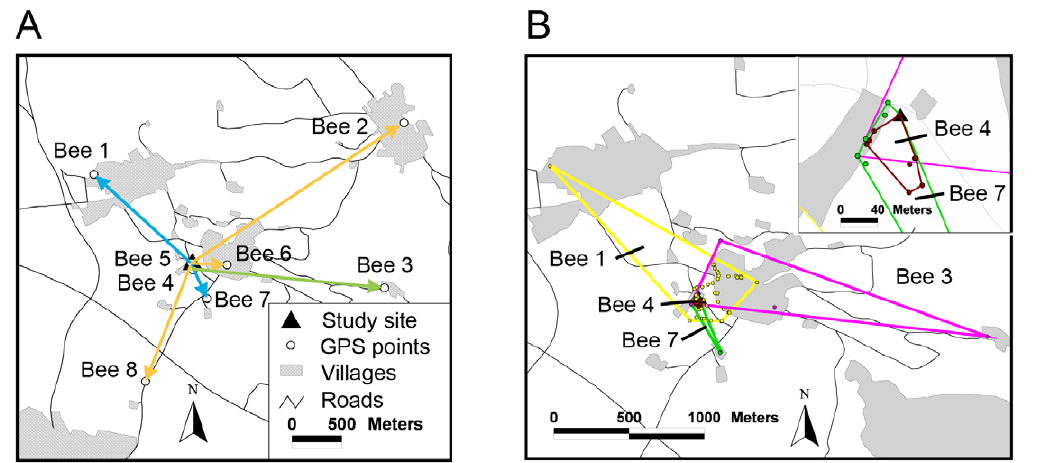
Figure 3. Flight distances and home ranges of bumblebees. ( a ) Maximum flight distances (bees 1–8) recorded from radio-tracking. Blue arrows: Bombus hortorum individuals, green arrow: B. ruderatus , orange arrows: B. terrestris , (for distance estimates see Table 1). Note that bee 4 ( B. hortorum ) and bee 5 ( B. terrestris ) are not illustrated with arrows due to their short flight distances. ( b ) Estimated home ranges (minimum convex polygons[MCP] and observation points) for individuals with $ 5 point locations(bee 1, 4, 7 B. hortorum , bee 3 B. ruderatus ; see Table 1 for estimated home range sizes). Different colors represent different individuals (bee 1, 3, 4 and 7). The inset shows a more detailed view of the study site where the observation points of bee 4 (brown) and bee 7 (green) are plotted. Note that four observation points of bee 4 (lying on the MCP line) are covered by